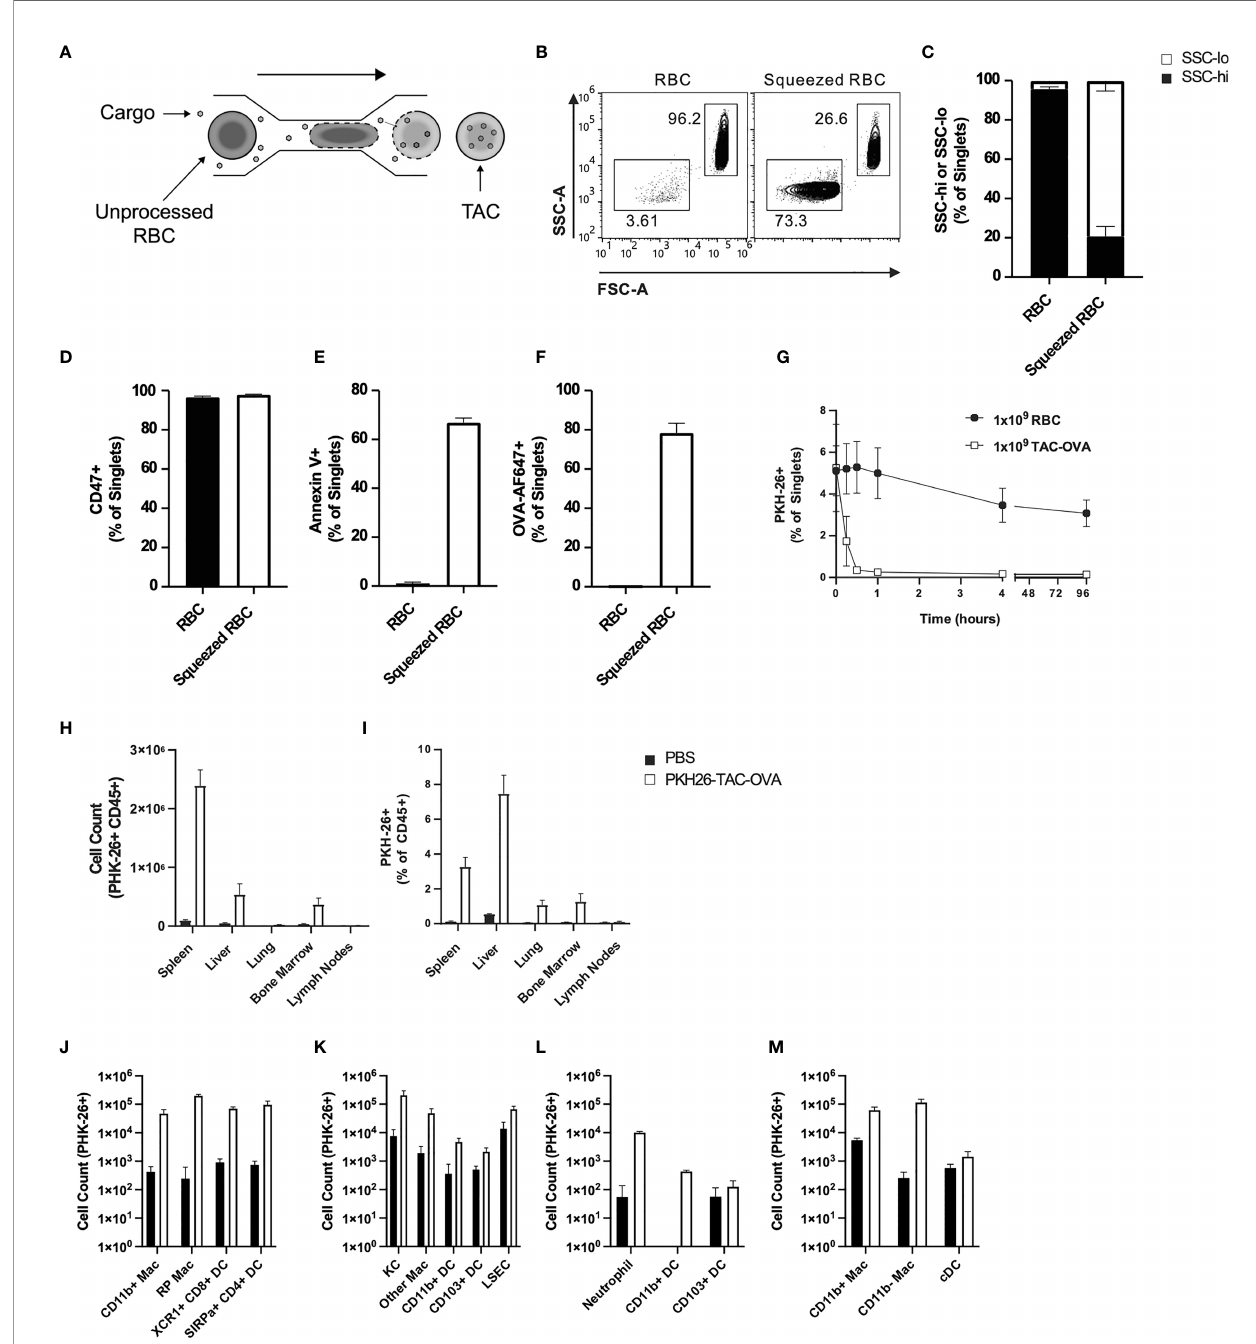
FIGURE 1 | TACs are Annexin V positive and are primarily engulfed by macrophages in the spleen and liver. (A) Schematic of micro fl uidic platform for squeezing RBC with target antigen to generate TAC. (B – F) Flow cytometry characterization of untouched RBC or RBC squeezed with OVA-647. (B) Representative and (C) quantitative fl ow cytometry of light scatter by untouched or squeezed RBC. Quanti fi cation of (D) CD47 and (E) Annexin V staining of and (F) OVA-647 delivery to squeezed versus untouched RBC. (B – F) are gated on singlets. (G – M) RBC squeezed with OVA (TAC-OVA) labeled with PKH-26 or controls (PKH-26 + RBC or PBS) were injected into C57BL/6 mice. (G) Frequency of peripheral blood singlets PKH-26 + at indicated timepoints post-injection. (H) Total count of PKH-26 + CD45 + cells and (I) frequency of PKH-26 + among CD45 + leukocytes cells in the indicated organs one-hour post-injection. (J-M) Uptake of PKH26 + TACs by various APC subsets in the (J) spleen, (K) liver, (L) lungs and (M) bone marrow one-hour post-injection. OVA squeeze concentration was 100mM (B – F) and 5mM for (G – M) . n=3 and representative of at least two independent experiments. Mean +/-